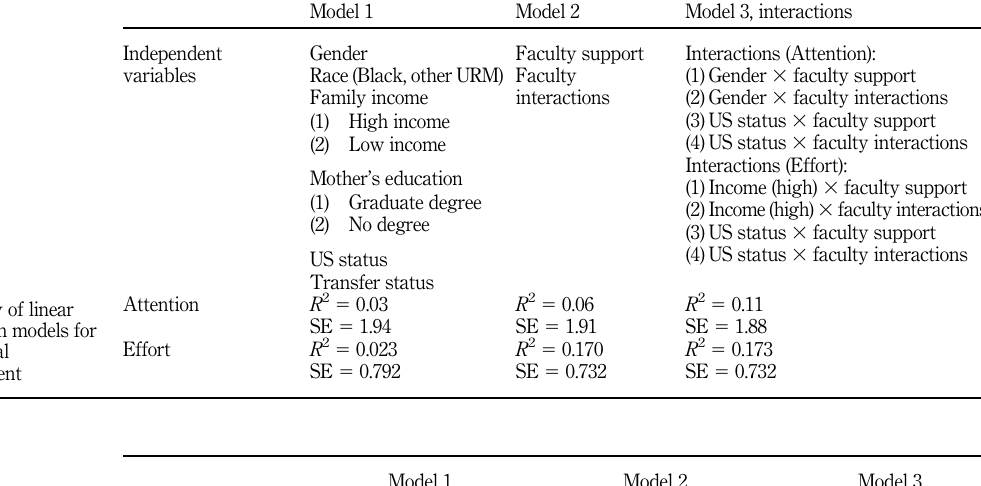
Table 4. Summary of linear regression models for behavioral engagement